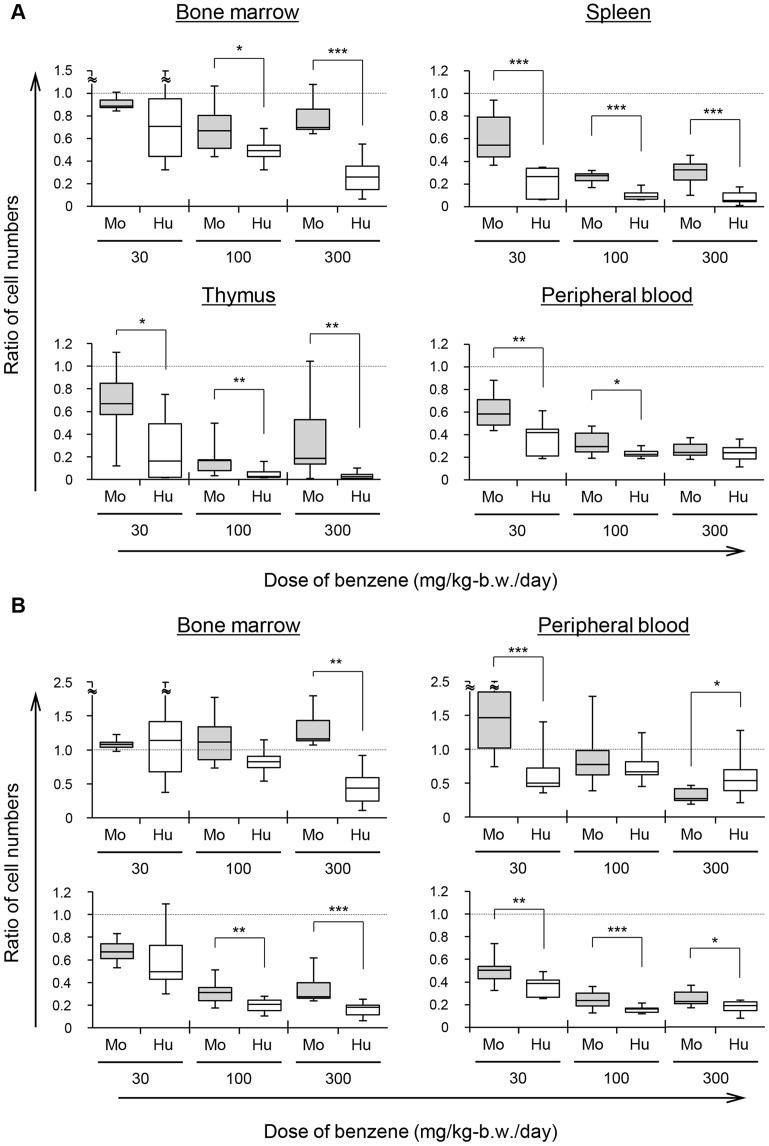
Comparison of benzene toxicity in Hu-NOG and Mo-NOG mice.(A) Ratios of donor cell-derived human or mouse leukocytes in Hu-NOG (Hu) and Mo-NOG (Mo) mice after benzene administration. Each ratio was calculated based on the mean number of leukocytes in untreated Hu-NOG or Mo-NOG mice. (B) Ratios of myeloid (upper) and lymphoid (lower) cells in the bone marrow and peripheral blood of Hu-NOG (Hu) and Mo-NOG (Mo) mice after benzene administration. Each ratio was calculated based on the mean number of myeloid and lymphoid cell in untreated Hu-NOG or Mo-NOG mice. Mouse myeloid cells in Mo-NOG mice were identified as mCD45.2+mCD45.1−mLy6C/6Ghi/mid. Mouse lymphoid cells in Mo-NOG mice were identified as mCD45.2+mCD45.1−mLy6C/6Glo/−. The box plot shows the maximum (top of the vertical line), 75th percentile (top of the box), median (middle line in the box), 25th percentile (bottom of the box), and minimum (bottom of vertical line) values of data (n = 6–8). * p<0.10 represents marginally significant differences between Hu-NOG and Mo-NOG mice, as determined by Mann-Whitney U tests. ** p<0.05 and *** p<0.01 represent significant differences.